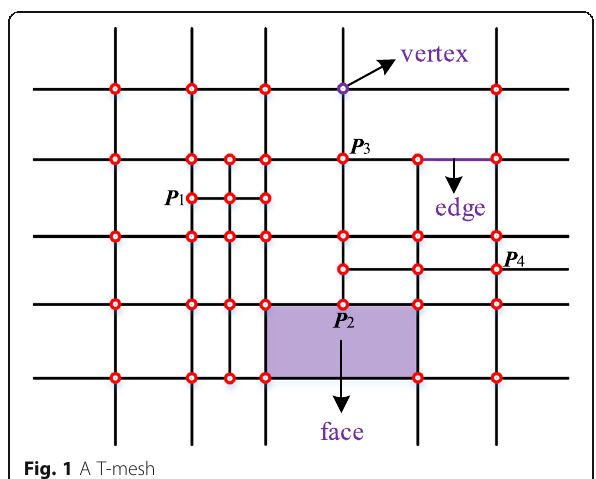
Fig. 1 make the topological structure of T-splines very flexible. After a valid knot interval configuration being assigned to the edges, the topology information of T-splines is determined.